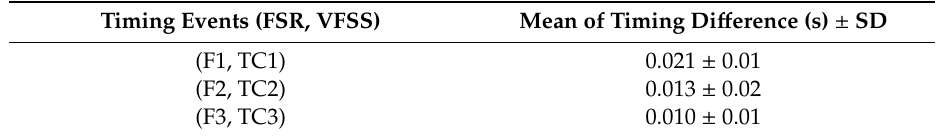
Table 5. The timing difference between the FSR and the thyroid cartilage movement using the VFSS.